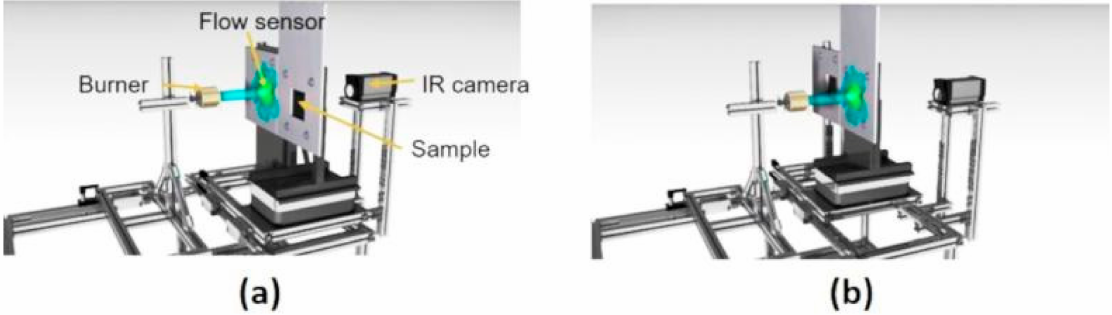
Figure 3. Burn-through test bench illustration [18] ( a ) Flame calibration, ( b ) Switch between calibration to sample.